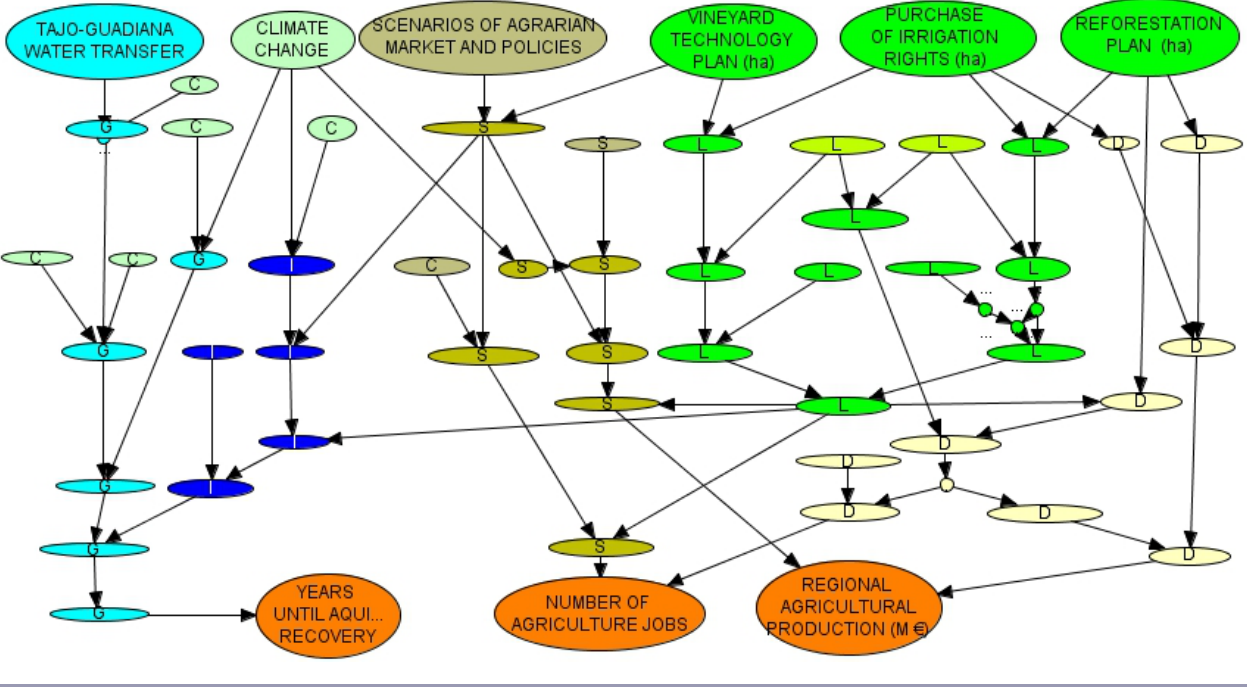
Fig. 2 . Bayesian network of the Upper Guadiana basin at aquifer-scale (Zorrilla 2009). “G and light blue” variables refer to groundwater; “I and blue” represent irrigation variables; “C and light green” variables correspond to climate; “S and brown” variables represent socio-economic scenarios; “L and green” variables relate to irrigated land; and “D and yellow” variables represent rain-fed agriculture. Appendix 1 provides a full representation of the aquifer-scale Bayesian